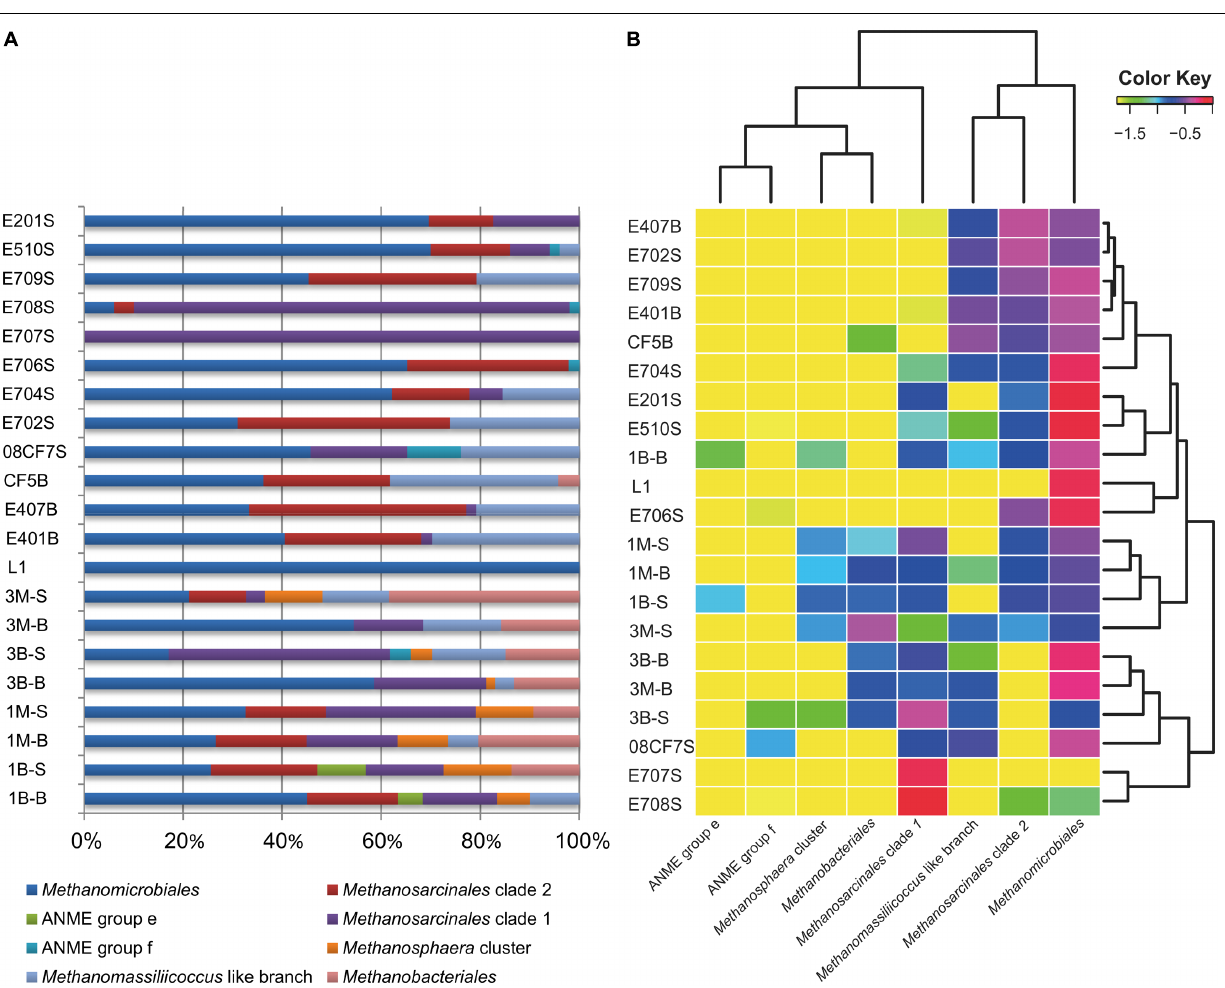
FIGURE 3 | Visualized mcrA gene-harboring archaea composition, abundance and distribution pattern in each sample. (A) Proportional barchart based on the clone numbers of each group mcrA harboring archaea in each sample; (B) Log-normalized heatmap made by Rstudio based on the proportion data of clone numbers of each group mcrA gene-harboring archaea in each sample. Dendrogram was used to